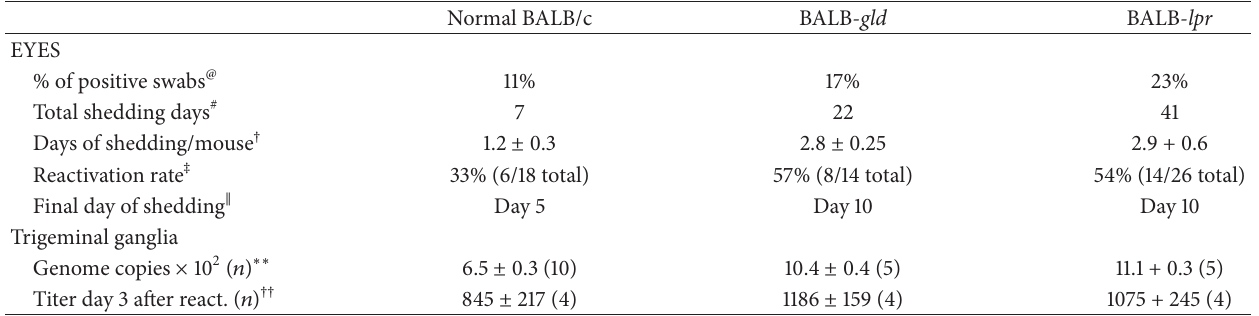
Table 1: HSV-1 shedding following UV-B reactivation.